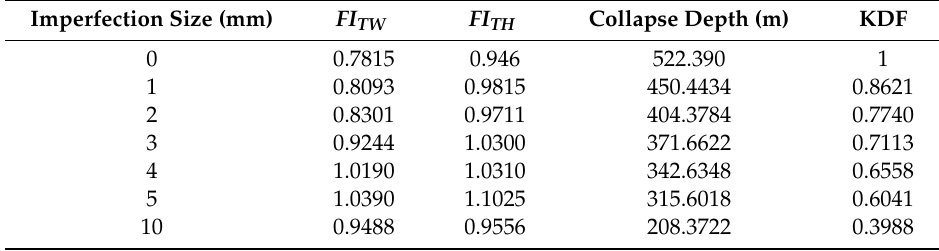
Table 11. Effect of imperfection on the collapse depth for worst mode imperfection. Table 11. E ff ect of imperfection on the collapse depth for worst mode